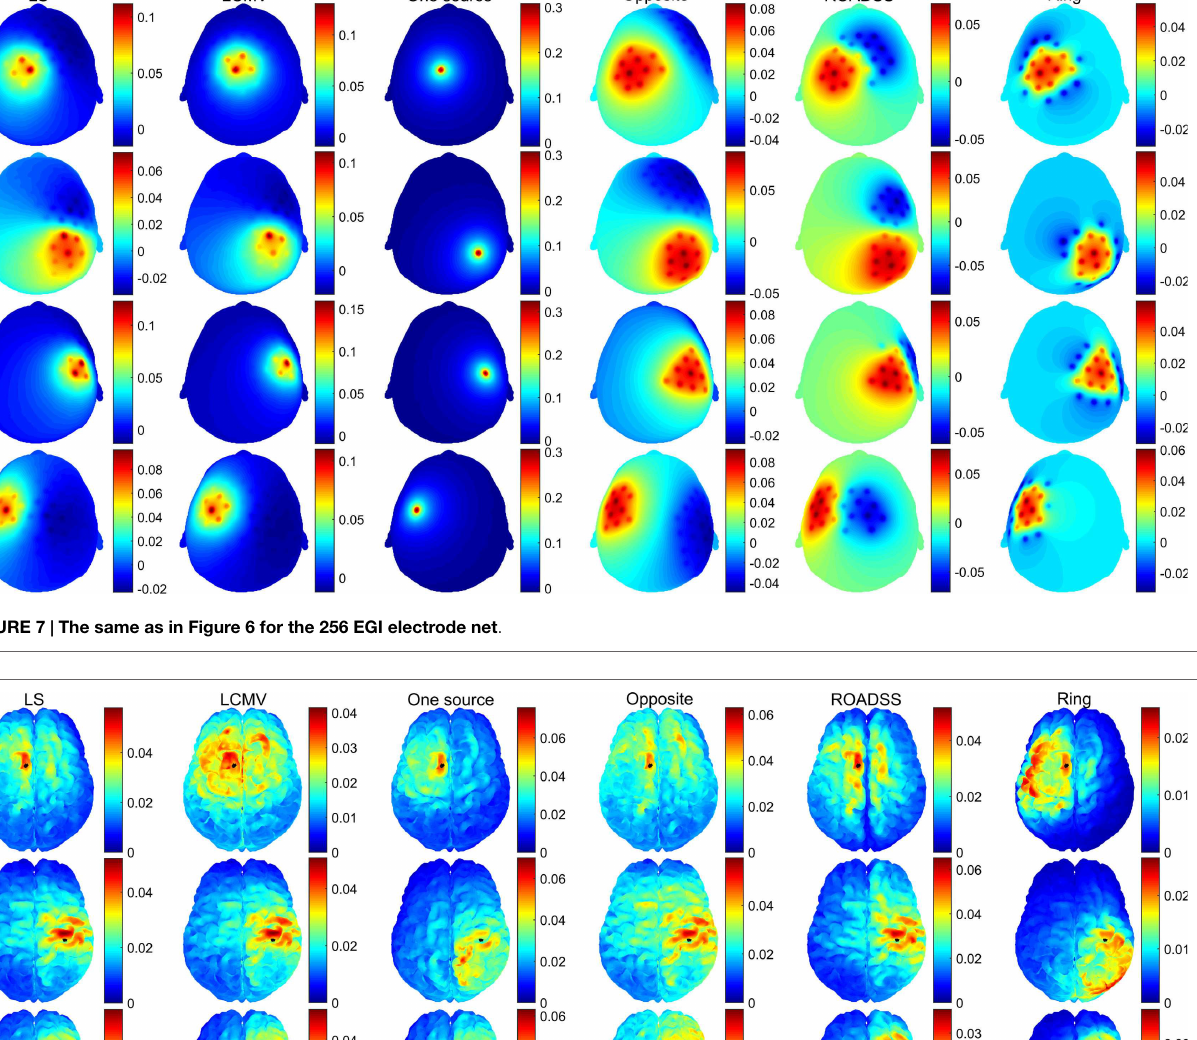
FIGURE 8 | Module of the total delivered current density on the cortex for the 128 EGI electrode net in ampere/square millimeter . Rows from top to bottom correspond to optimal stimulation of targets T1, T2, T3, and T4; columns correspond to the optimal current injection patterns obtained, from left to right, with the LS, LCMV, “one source,” “opposite,” “ROADSS,” and “ring” methods. The total current injected in each case is 1mA. The cortical ROIs to target are shown in